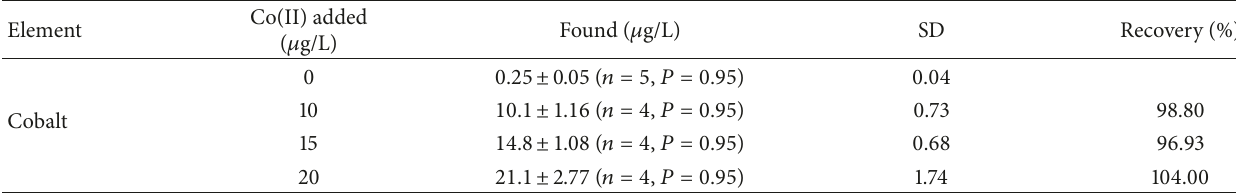
Table 3: Analytical results for cobalt in seawater.